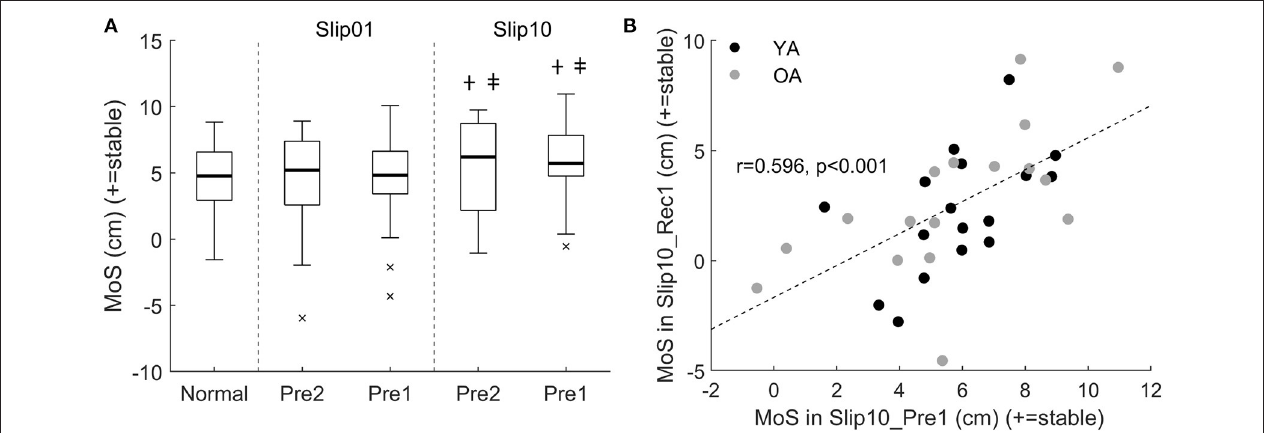
FIGURE 2 | (A) Boxplots of the margin of stability (MoS) for all participants in the two steps prior to Slip01 and Slip10 (Pre2 and Pre1). Thick horizontal black lines: median; thin horizontal black line: first and third quartiles; × : outliers. †: Slip10 significantly higher than normal ( p ≤ 0.005); ‡: Slip10 significantly higher than Slip01 ( p ≤ 0.023). See Supplementary Figure 1 for participants’ data points. (B) Correlation between MoS in Slip10_Pre1 and MoS in Slip10_Rec1, r = 0.596, p < 0.001. Black circles: young adults (YAs); grey circles: older adults (OAs).